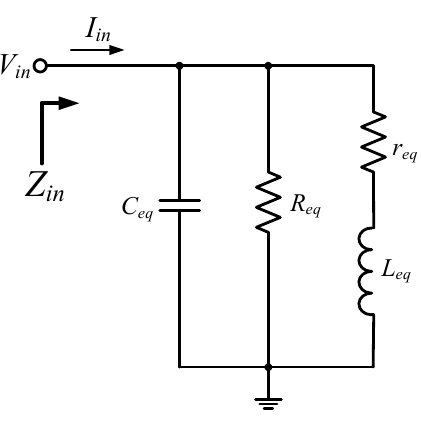
Figure 4. Equivalent model of the proposed simulated inductor.